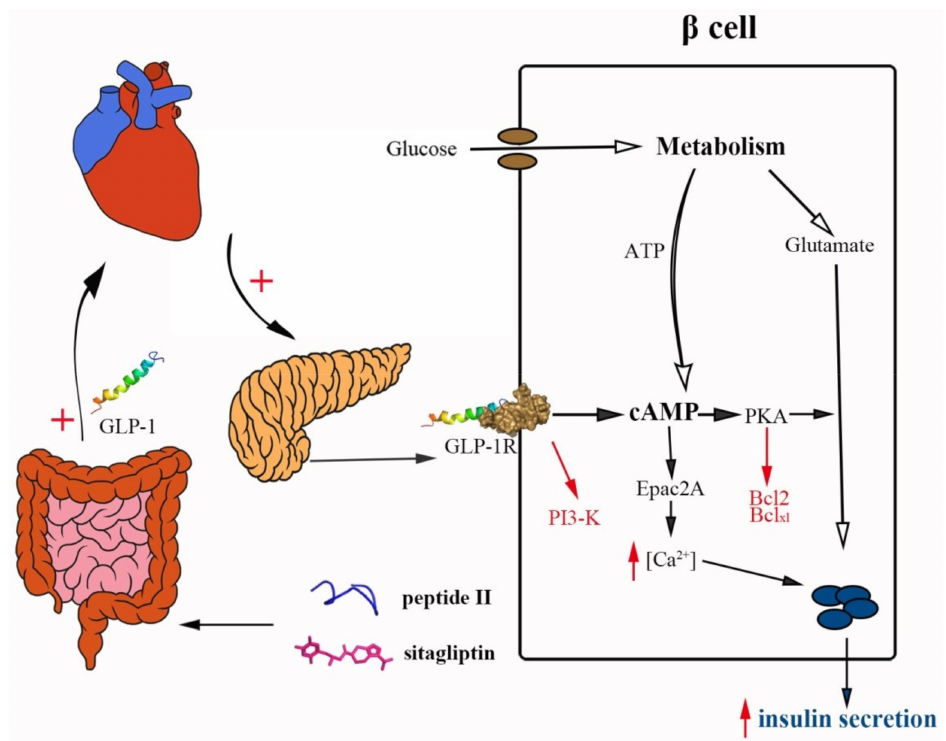
Figure 5. The role of peptide II and sitagliptin as dipeptidyl peptidase-IV (DPP-IV) inhibitors. Glucagon-like peptide-1 (GLP-1) is released from the enteroendocrine cells in the gastrointestinal tract, then diffuses into the capillaries where degradation by DPP-IV and circulating in the plasma begins. Further degradation occurs during passage through the liver, as well as on the way to pancreatic islet. The intake of peptide II and sitagliptin inhibits the activity of DPP-IV and remains in the concentration of GLP-1 in plasma. The GLP-1 receptor activation in the pancreatic beta-cells leads to insulin secretion via the stimulation of incretin/cAMP pathways and recruits signaling mechanisms, leading to cell survival. The figure is reproduced from